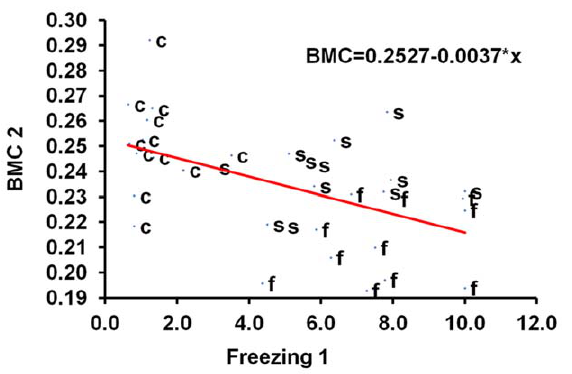
Figure 7. Comparisons of BMC reductions in total body and specific bone sites between low and high freezing response groups of mice. All parameters were obtained at week 7. Values are means and S.E.M of percentage reductions compared to the control. The significance of each group compared to the control for each parameter is indicated by the actual P value or an asterisk for P , 0.05 inside the corresponding bar. The low and high freezing response groups were defined as having the freezing time in the lowest and the highest 33% percentiles, respectively. The mean freezing time in the low response, high response and control group was 1.15, 5.35 and 1.24 sec, respectively. While there was a significant difference between the high response and control group for the freezing time, the difference between the low response and control group was not significant.